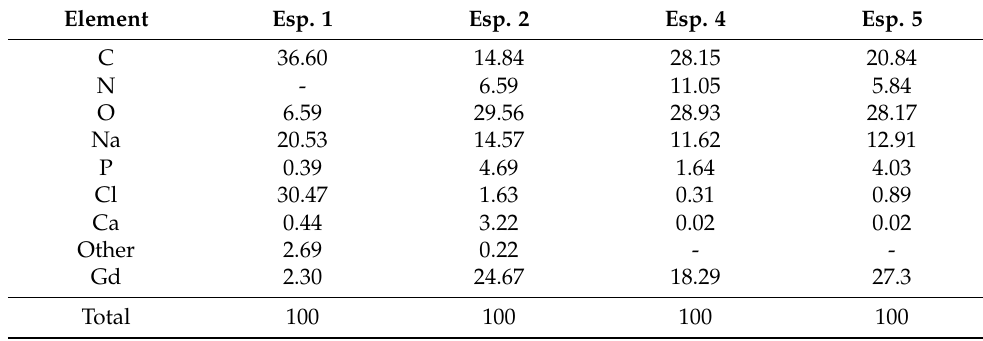
Table 2. EDX values obtained for each element present in the samples.